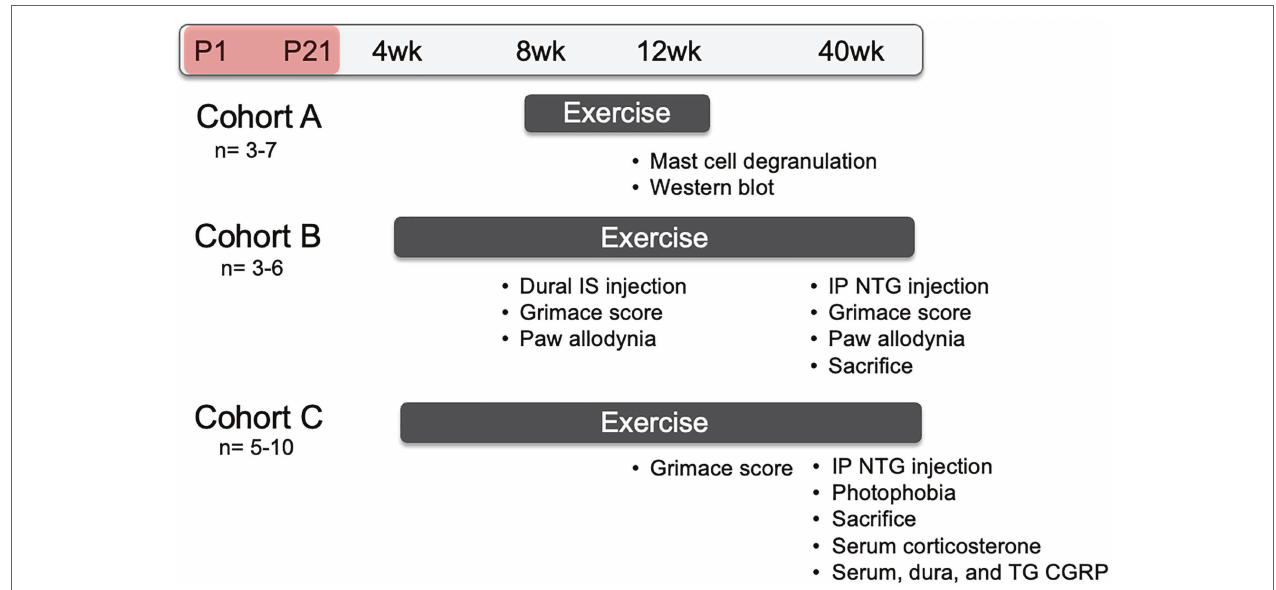
FIGURE 1 | Representative timeline of evoked migraine experiments and outcome measures. All groups consisted of mice that underwent neonatal maternal separation (NMS) from postnatal day (P) 1 to 21 (depicted as the red shaded period) and non-separated, naïve mice. Mice in Cohort A were singly-housed with running wheels at 8 weeks of age and sacrificed at 12 weeks of age. Dura mater was collected to evaluate mast cell (MC) characteristics and measure protein level using Western Blot. Mice in Cohort B were pair-housed with running wheels at 4 weeks of age. At 8 weeks of age, they received either inflammatory soup (IS) or saline applied to the dura mater and, 1 h later, mouse grimace score (MGS) was measured over 1 h. Forepaw mechanical withdrawal threshold was measured immediately after cessation of MGS. At 40 weeks of age, Cohort B mice received a single intraperitoneal (IP) injection of nitroglycerin (NTG) and 30 min later were assessed for MGS over 1 h, immediately followed by hindpaw mechanical withdrawal threshold. Mice in Cohort C were also pair-housed with running wheels at 4 weeks of age and assessed for MGS, without dural stimulation of NTG, at 12 weeks of age. The mice were given an IP NTG injection at 40 weeks, followed 30 min later by photophobia testing and sacrifice. The level of corticosterone was measured in the serum and the level of calcitonin gene-related peptide (CGRP) was measured in the serum, dura, and trigeminal ganglia